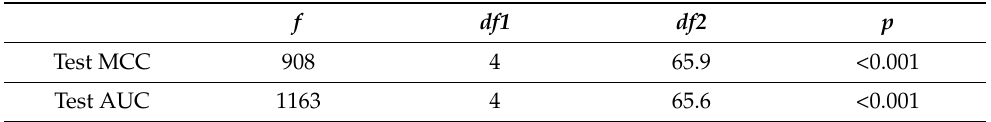
Table A4. The results of one-way ANOVA analysis (Welch’s